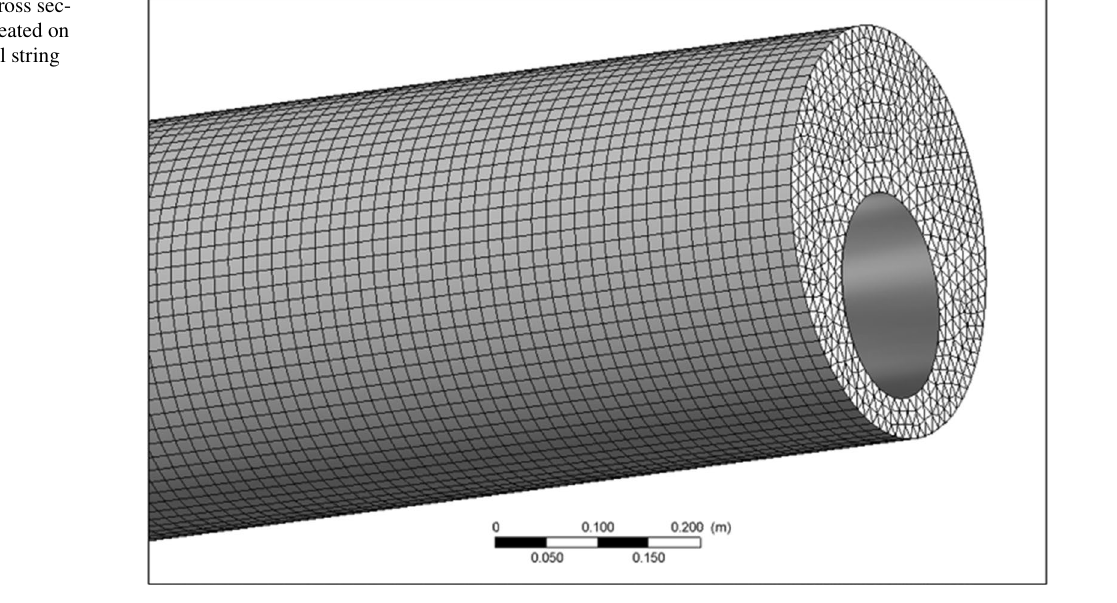
Fig. 6 Longitudinal cross sec- tion of the network created on eccentric annulus-drill string geometry